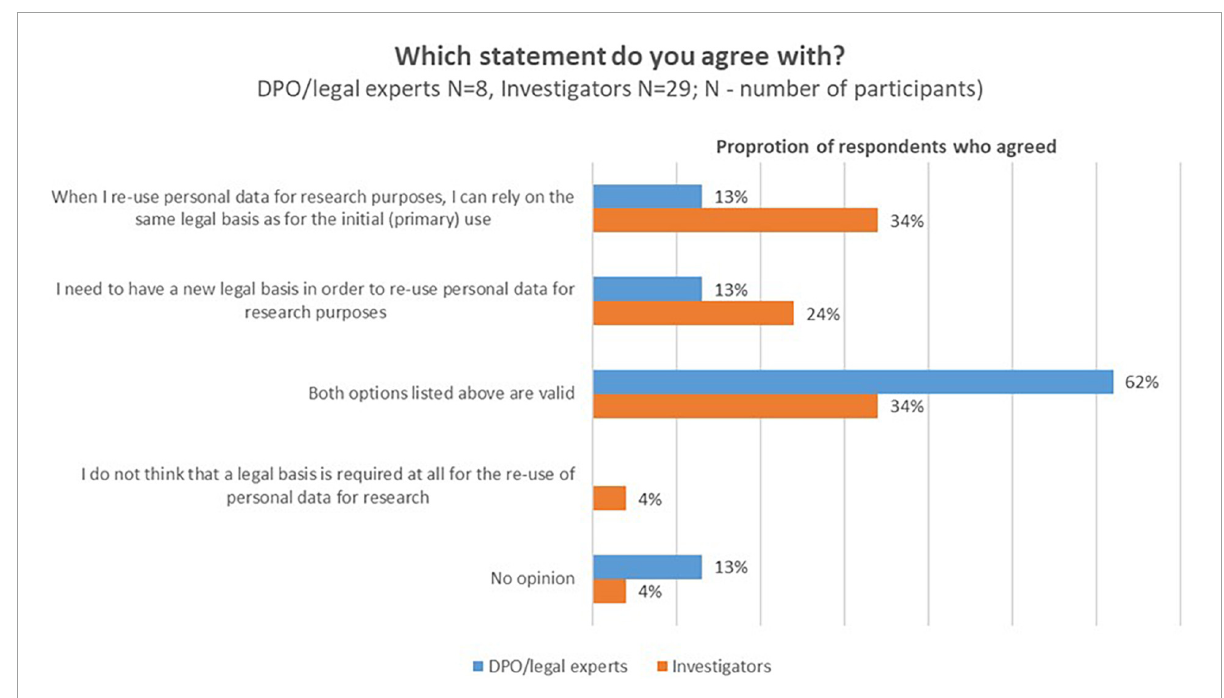
FIGURE4 DPOs/legal experts’ and investigators opinions about the need for a new legal basis when data is processed for secondary use.